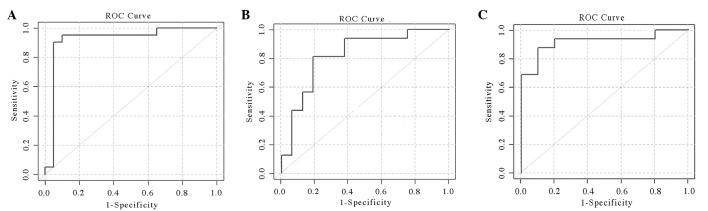
Validation set ROC curves. (A) Distinguishing AL patients from healthy controls (AUC, 0.921). (B) Distinguishing newly-diagnosed AL patients from AL-HCR patients (AUC, 0.824). (C) Distinguishing AL-HCR patients from those achieving deep remission, including M2/M3 patients with MR (AL-MR; AUC, 0.919). ROC, receiver operating characteristic; AL, acute leukemia; AUC, area under the ROC curve; HCR, hematological complete remission; MR, molecular remission.